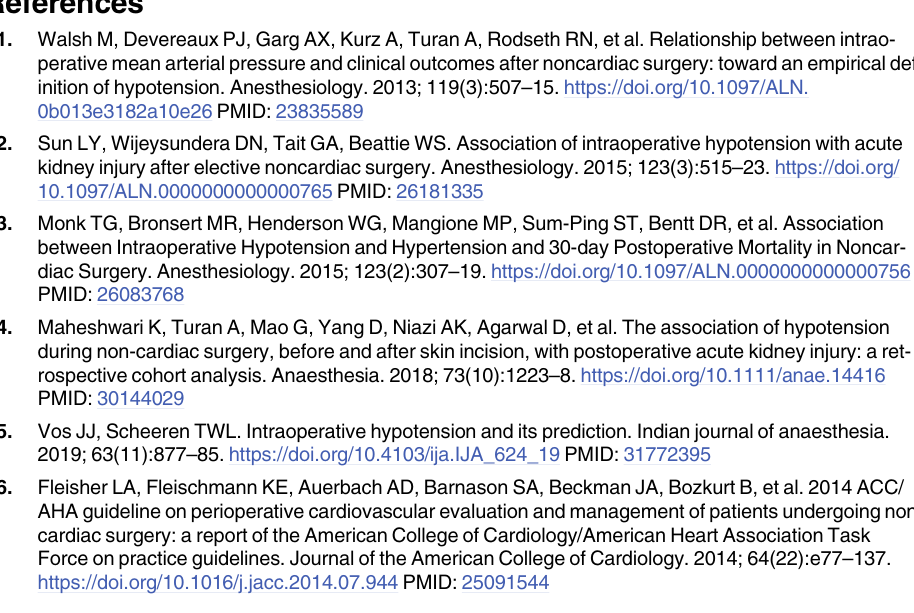
S2 Table. Transthoracic echocardiography